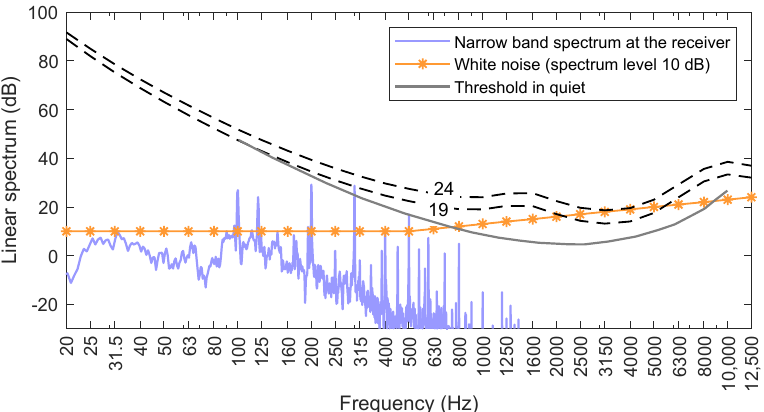
Figure 20. Masking of the tonal component using a white noise. Dashed lines: equal loudness contours at 19 phon and 24 phon. Threshold in quiet adapted from